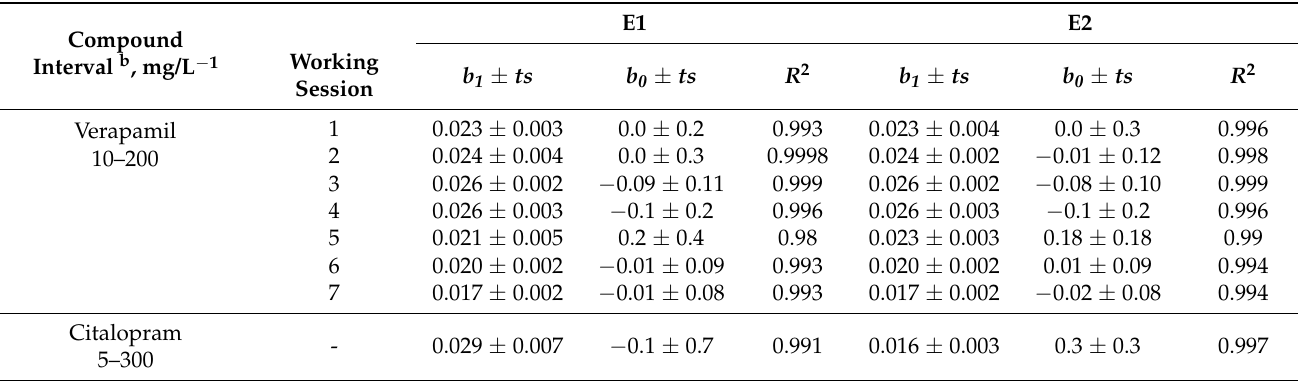
Table 2. Calibration statistics a for verapamil and citalopram along working sessions. Regression curve equation ( A / A i.s. = b 0 + b 1 S ), obtained using the internal standard